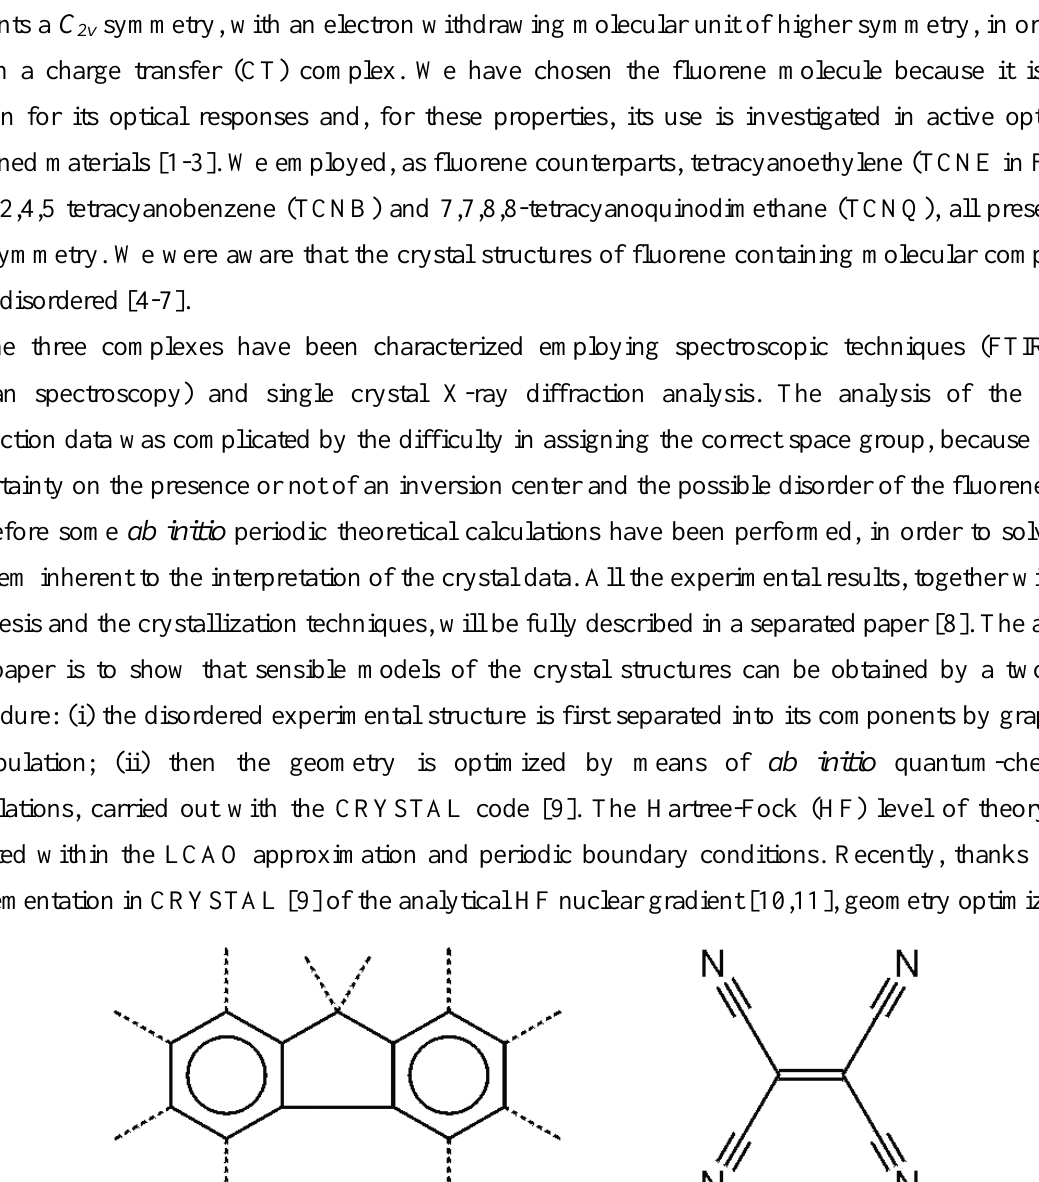
Figure 1. Fluorene and its D dotted